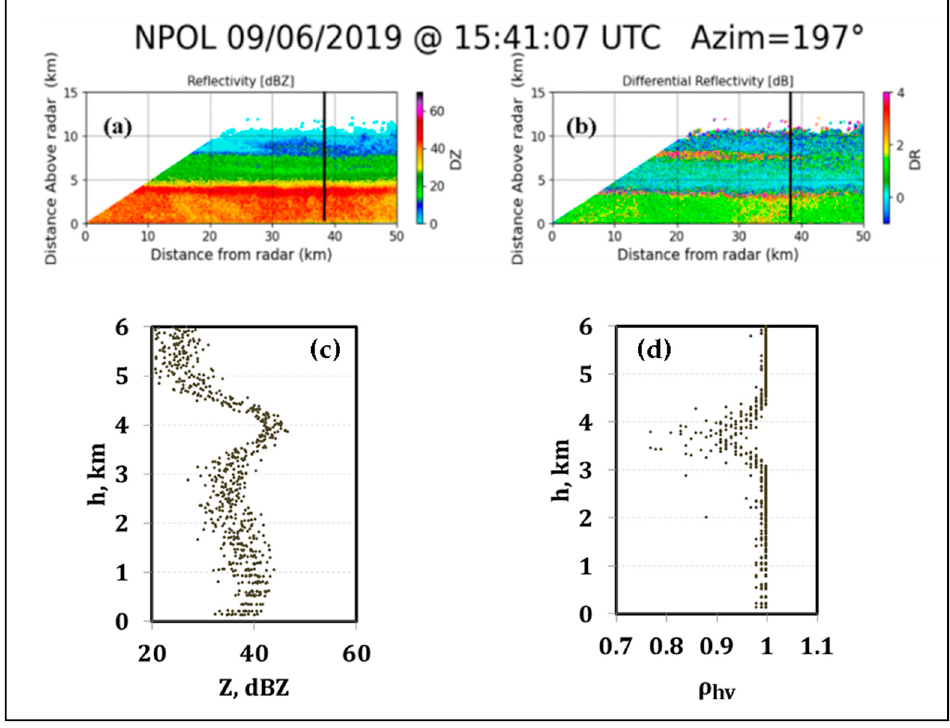
Figure 10. ( a ) RHI scan of Z h , ( b ) Z dr during a stratiform rain event (with a thick bright band) on 6 September 2019, i.e., rain bands of Dorian storm, and ( c , d ) vertical profiles of Z h and ρ hv respectively, over the disdrometers (black lines in panels ( a , b )).